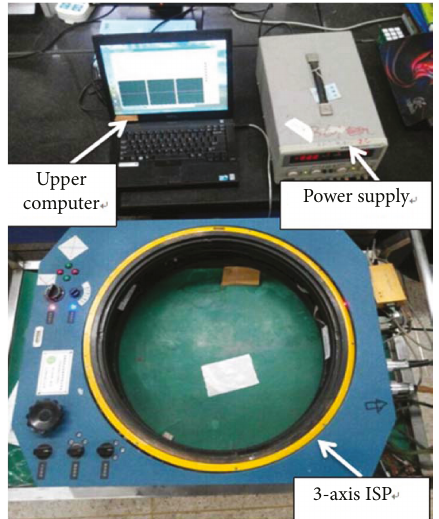
Figure 16: The picture of the three-axis ISP system in levelling static